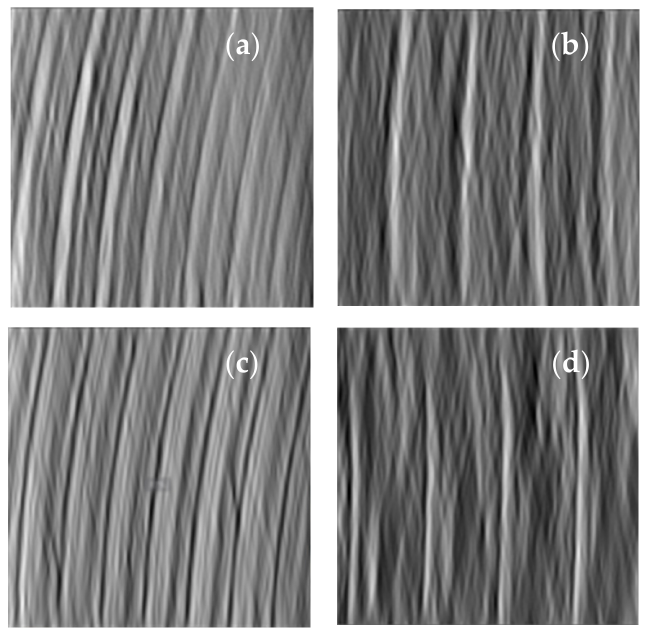
Figure 15. Typical samples of input images ( a ) Uneven texture; ( b ) High contrast; ( c ) Strong noise and ( d ) Insufficient exposure.